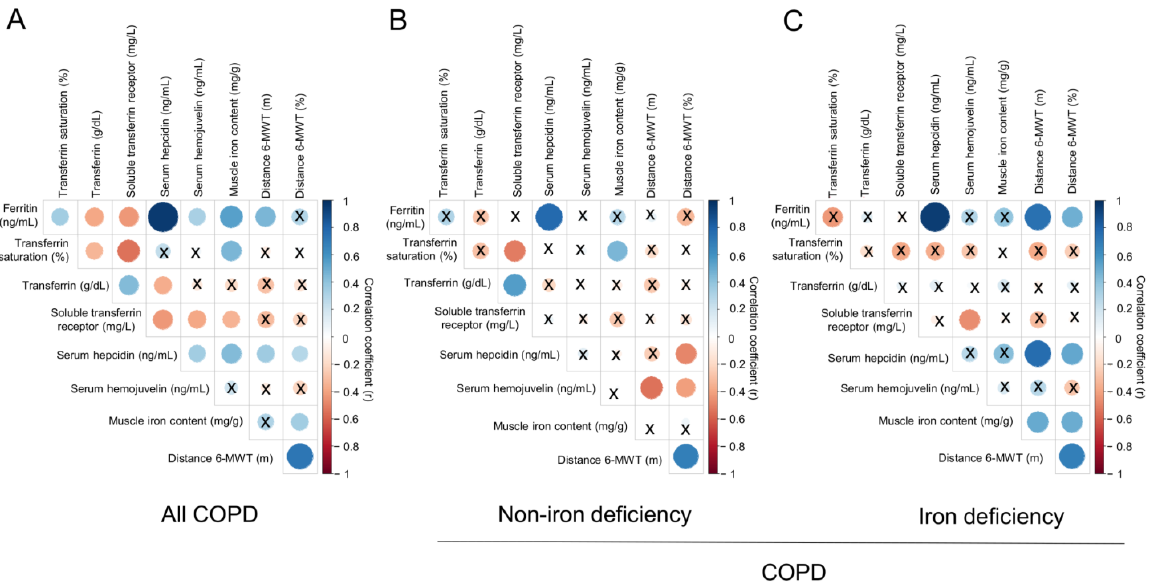
Figure 3. Correlation matrix of the iron metabolism parameters and six-minute walk test distance in ( A ) all COPD patients, ( B ) non-iron deficiency and ( C ) iron deficiency COPD patients. In matrix, blue color represents positive correlations, while negative correlations are indicated in red. Crosses inside the circle mean that the correlation is not statistically significant ( p value > 0.05). The correlation coefficients (Y axis of the graph) are proportional to the circle color intensity and size. Abbreviations: 6-MWT, six-minute walk test. Definition of abbreviations: COPD, chronic obstructive pulmonary disease.